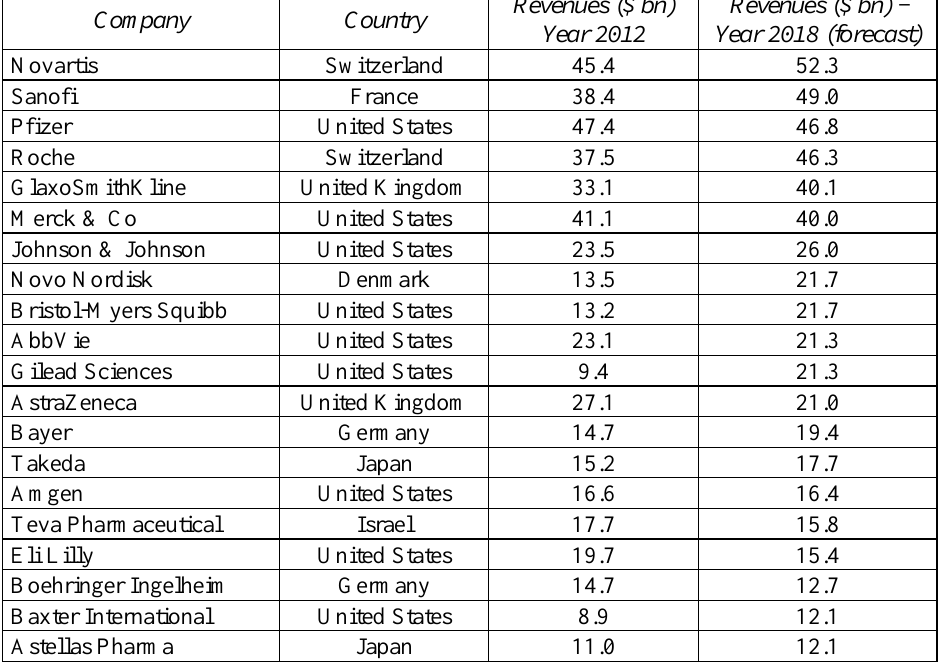
Table 1: Worldwide Prescription Drug Sales in 2012. Top 20